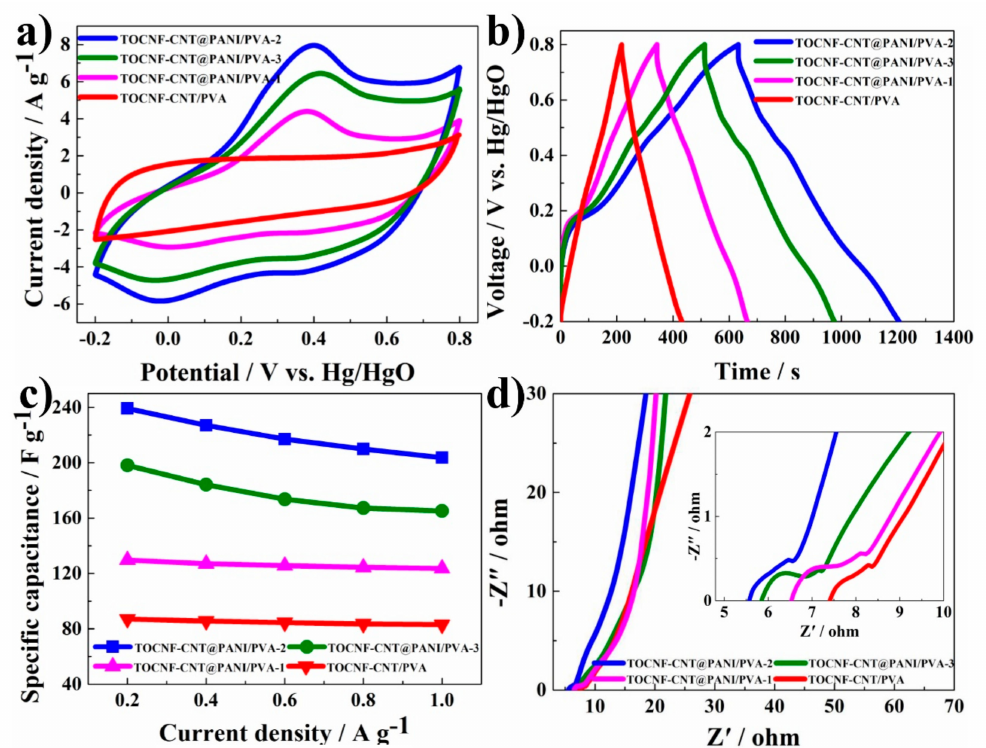
Figure 7. ( a ) CV (cyclic voltammetry) curves at 40 mV s − 1 scan rate; ( b ) G-CD (galvanostatic charge-discharge) curves at 0.4 A g − 1 current density; ( c ) specific capacitance of the hydrogel electrodes at di ff erent current densities; ( d ) Nyquist plot of hydrogel electrode and enlarged illustration of high-frequency